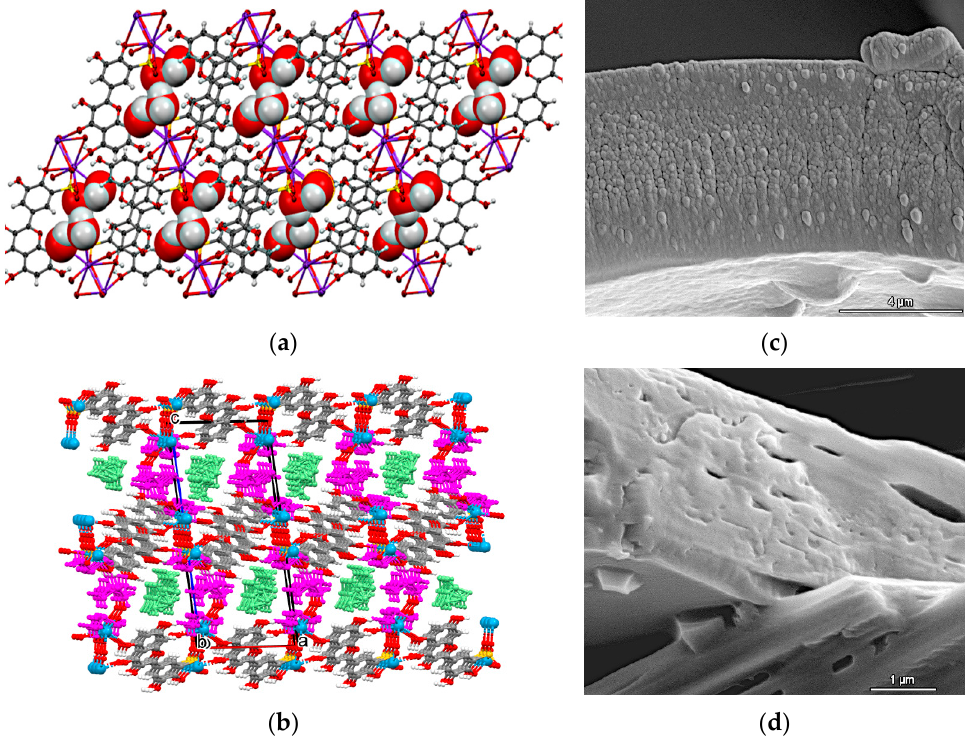
Figure 11. ( a , b ) Location of water and DMSO molecules in the net of crystals 1 and 3 , respectively. In 3 , solvating DMSO molecules are illustrated in green and coordinating ones—in magenta. ( c , d ) SEM micrographs under vacuum showing effects of solvent evaporation from the crystal network for 1 and 3 , respectively.